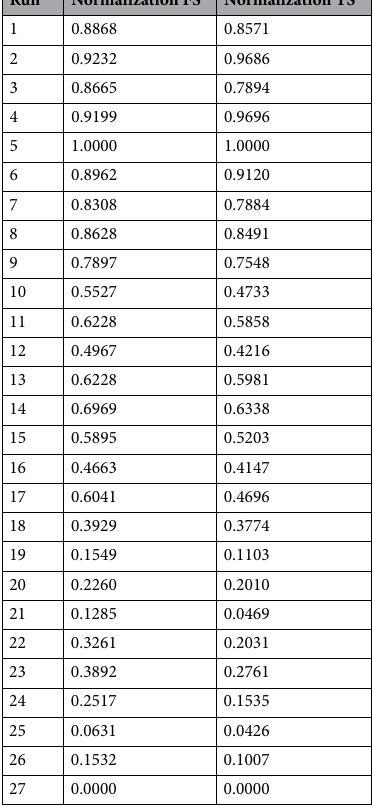
Table 5. Normalized decision matrix obtained in CRITIC method.